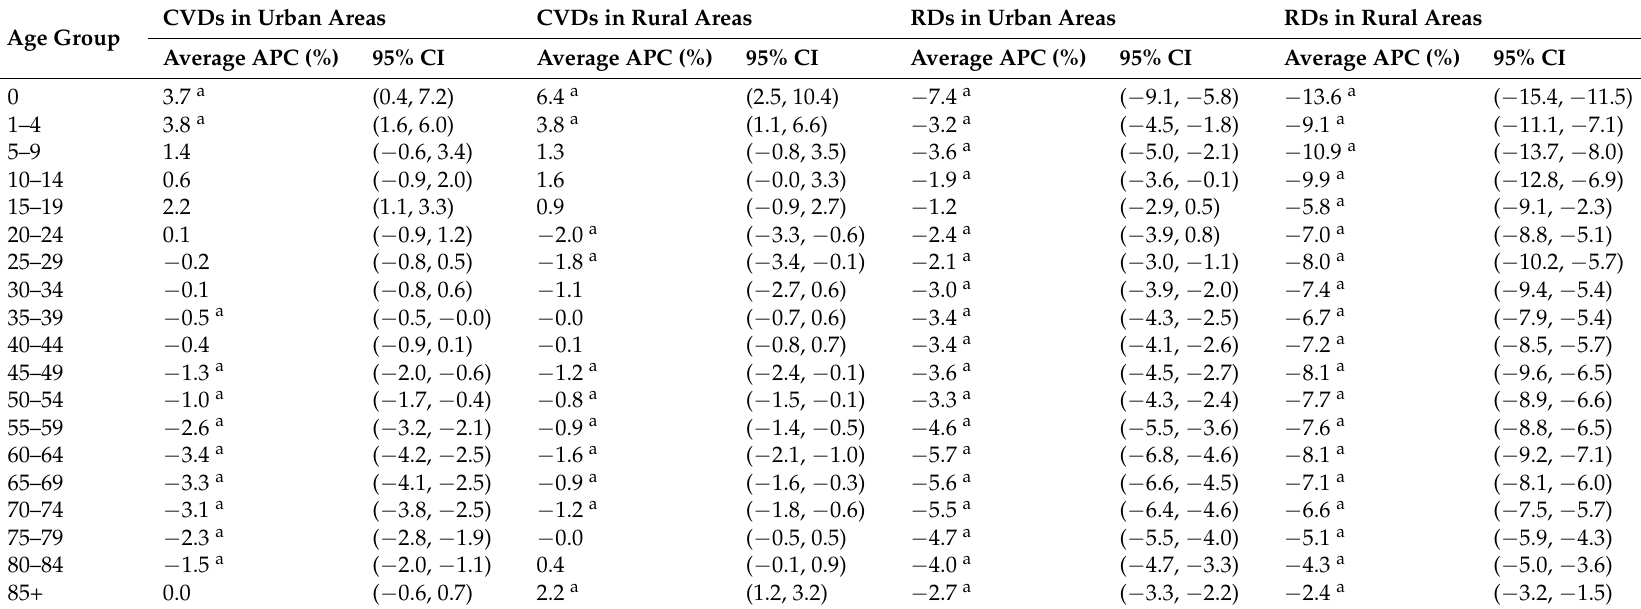
Table 2. APC in age-specific mortality rates from CVDs and RDs in urban and rural